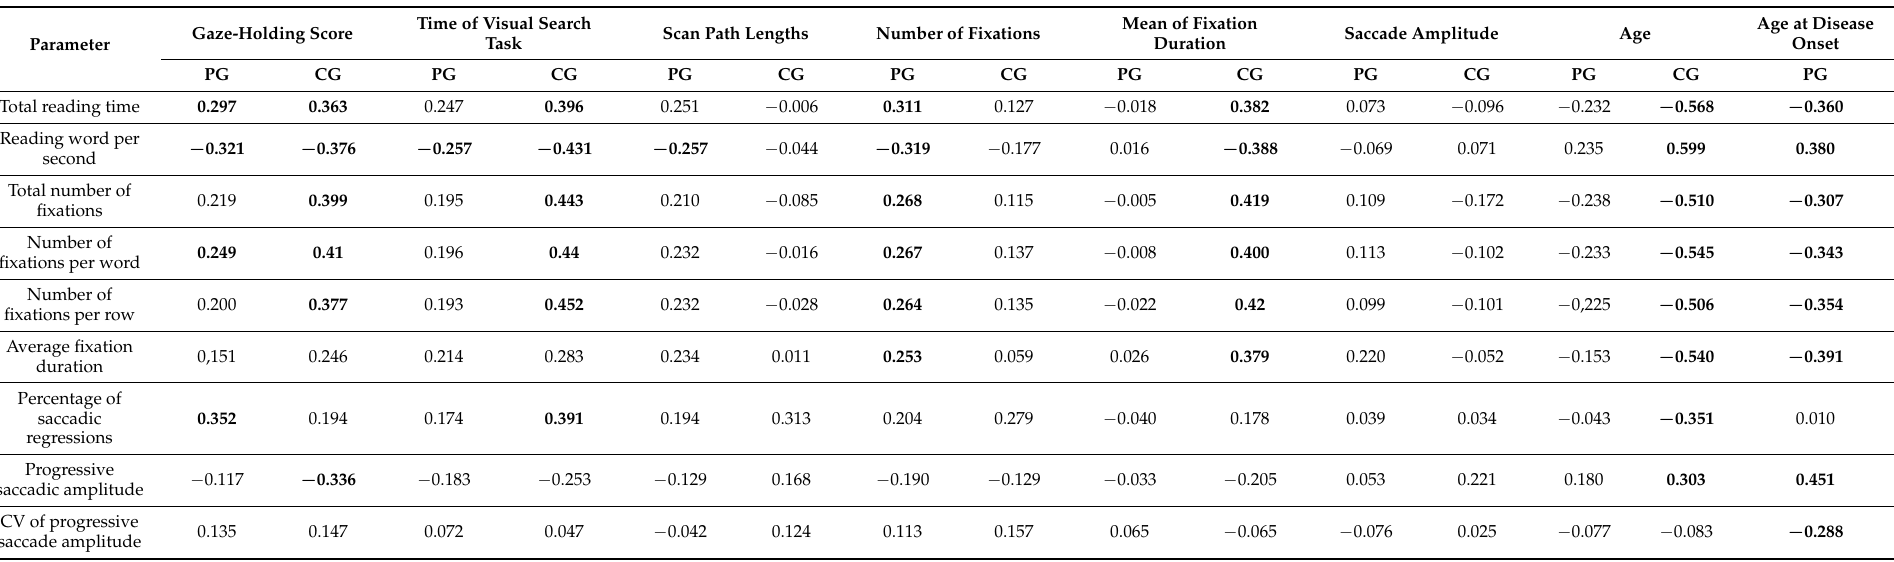
Table 3. Spearman’s rank correlation between the reading measures and two oculomotor tests. Values in bold are significant at p <